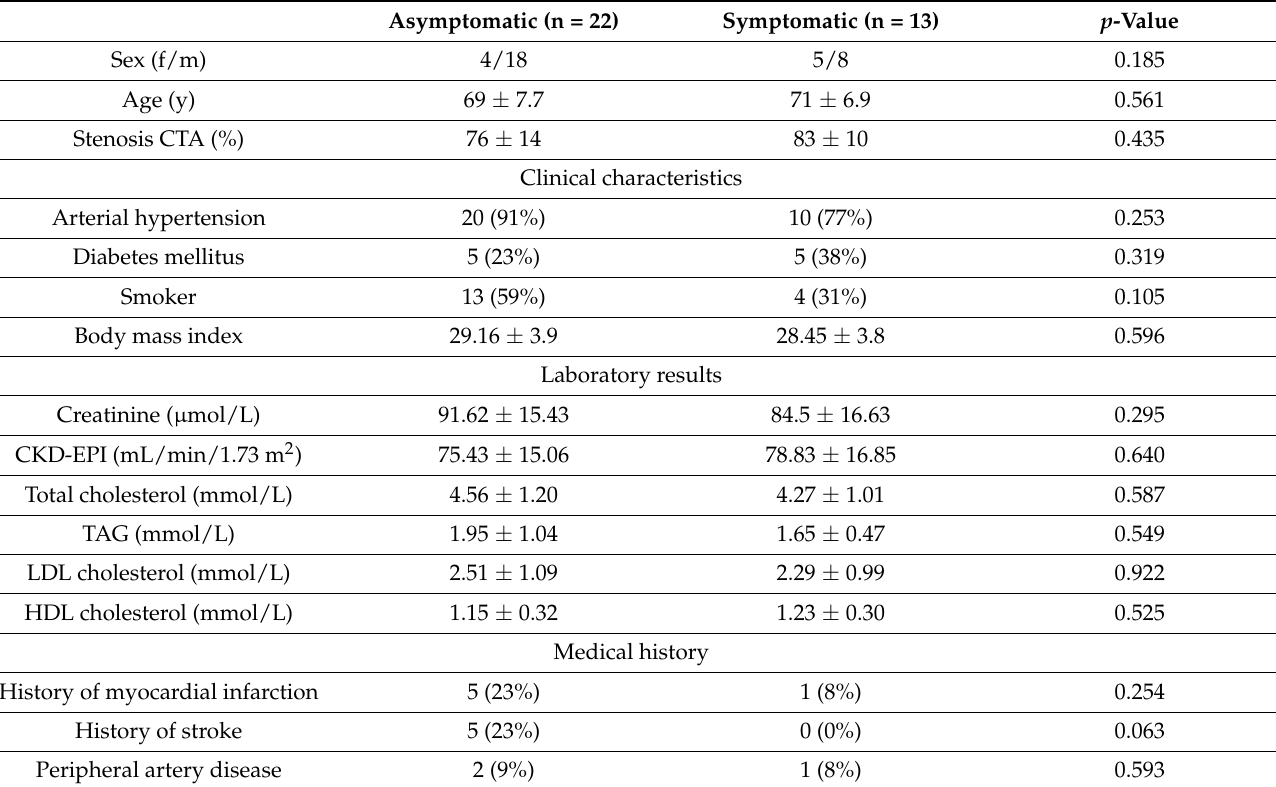
Table 1. Baseline characteristics. TAG—triglycerides; LDL—low-density lipoproteins; HDL—high-density lipoproteins; CKD-EPI—glomerular filtration. Variables are expressed as mean ± standard deviation. Asymptomatic (n = 22) Symptomatic (n = 13) p -Value